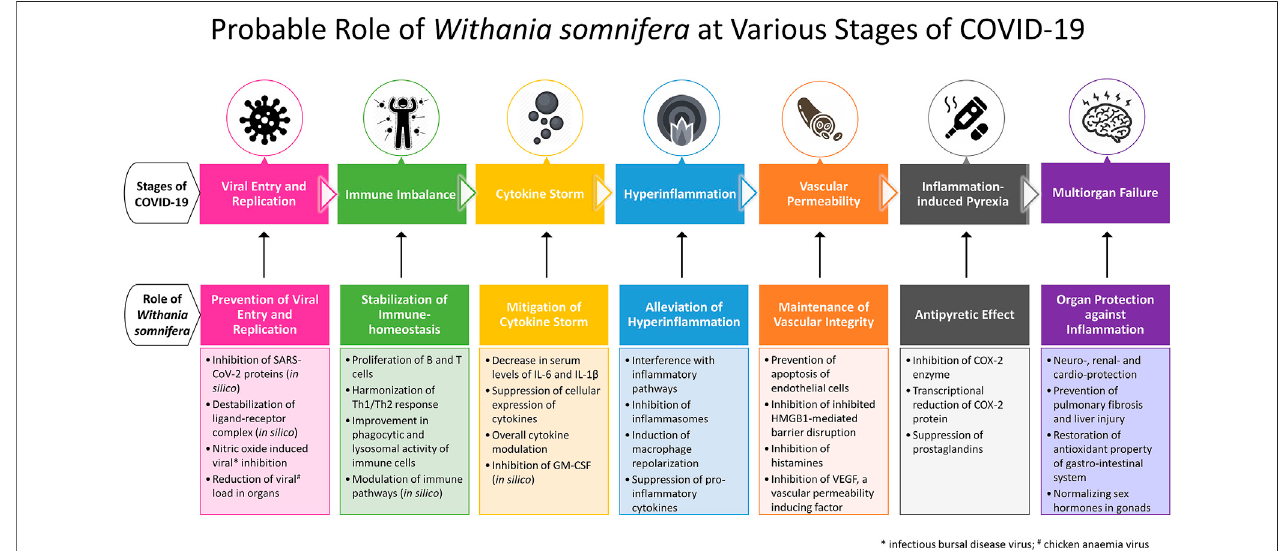
FIGURE 1 | Probable role of Withania somnifera at various stages of